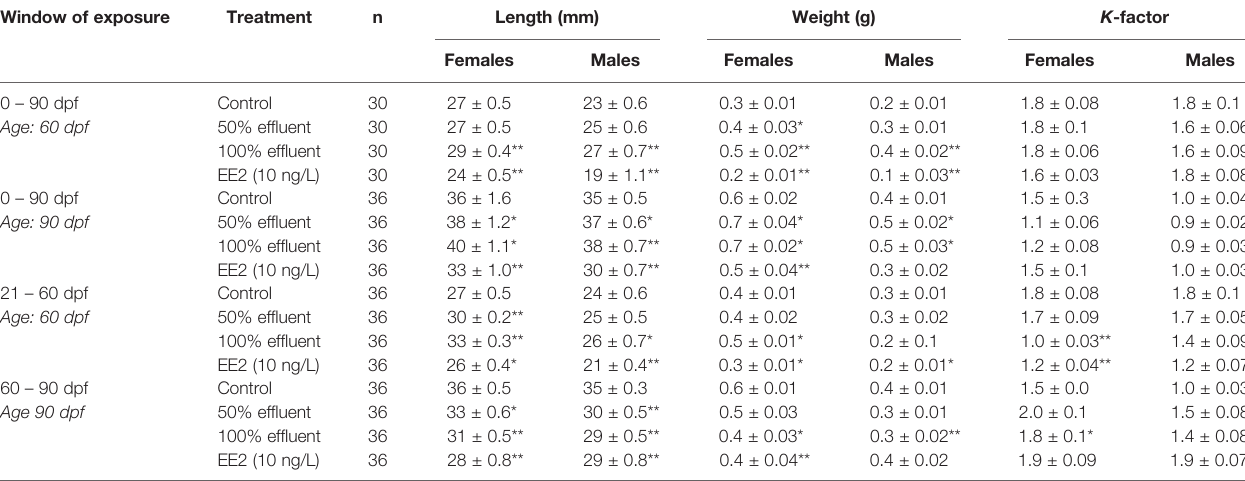
Data are reported as mean ± SE. Asterisks denote a signi fi cant difference (*p < 0.05, **p < 0.01) compared with system water